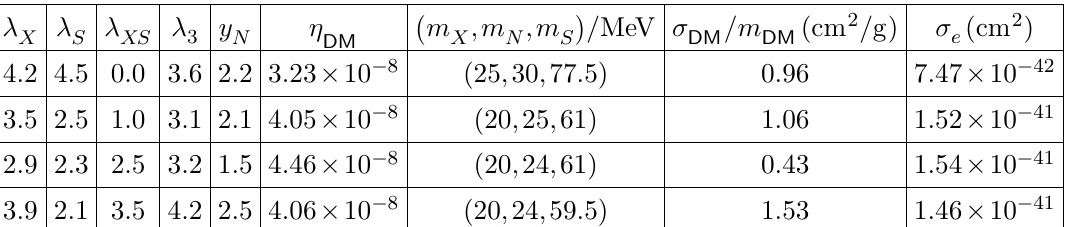
Table 2 . Benchmark points for r